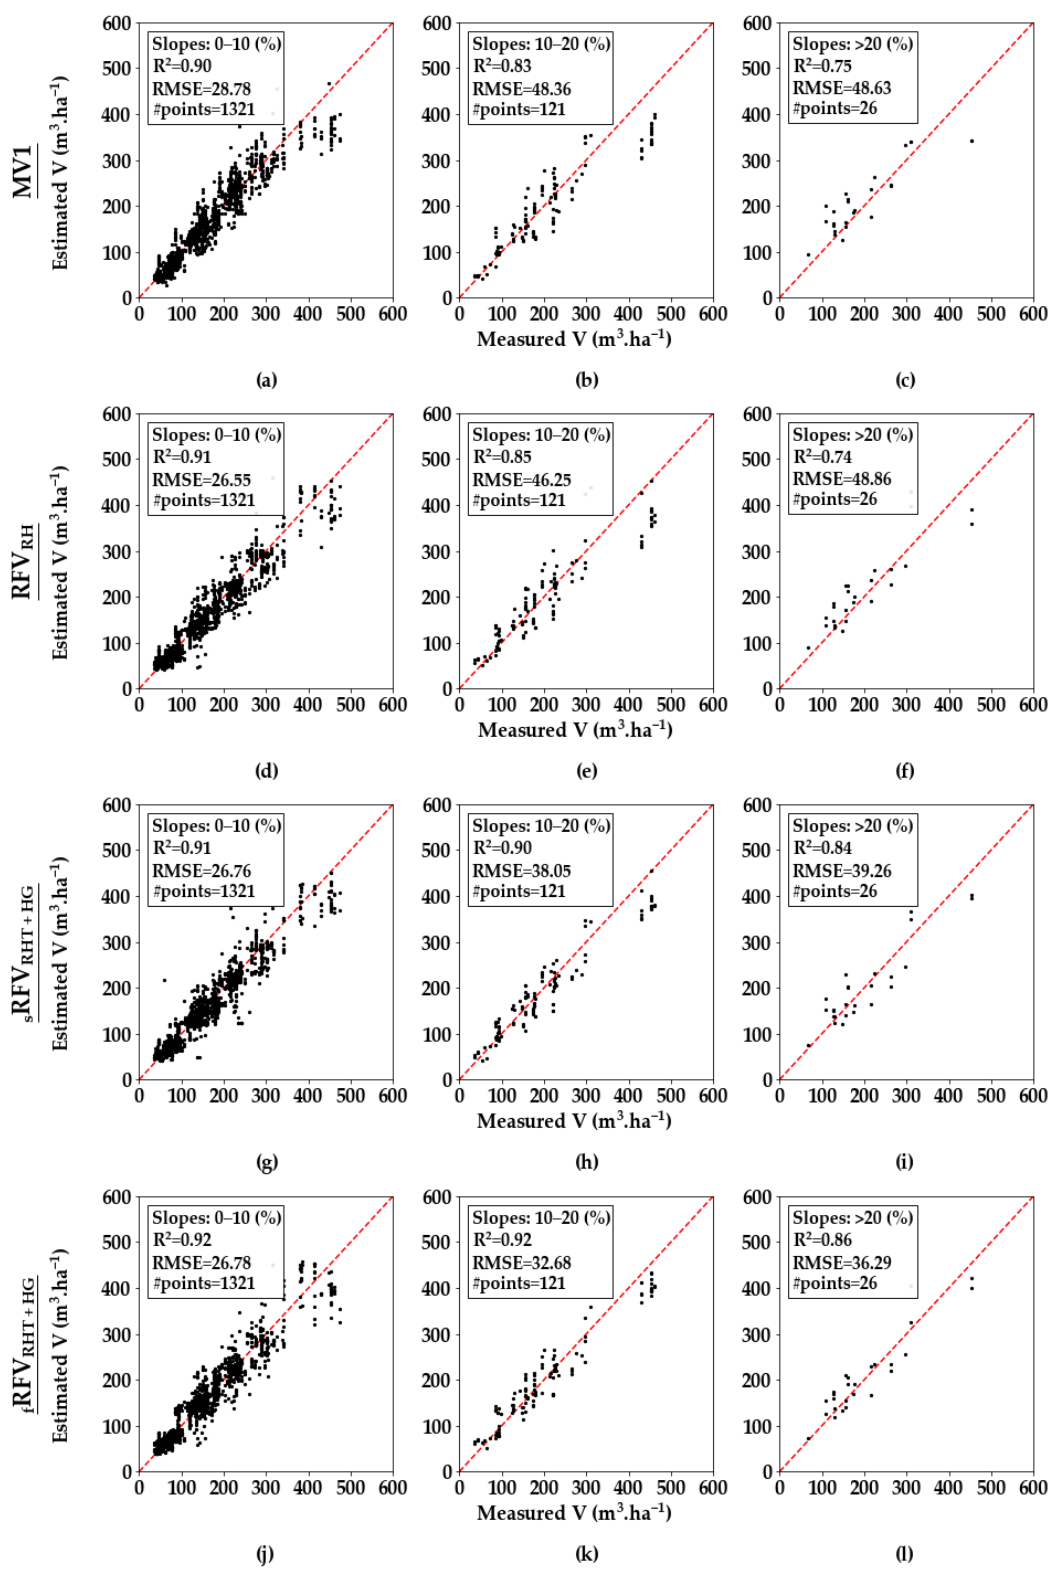
Figure 9. ( a – l ) Comparison of measured vs. estimated wood volume from the models presented in Section 3.2 using GEDI metrics extracted using algorithm a1. RMSE is expressed in m 3 · ha − 1